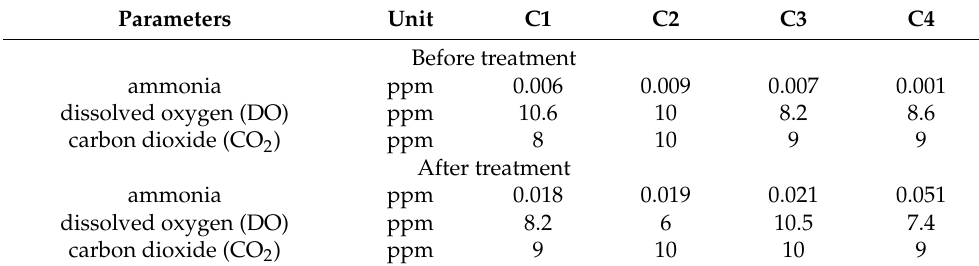
Table 4. Analysis of water quality in the study location of Bone Regency South